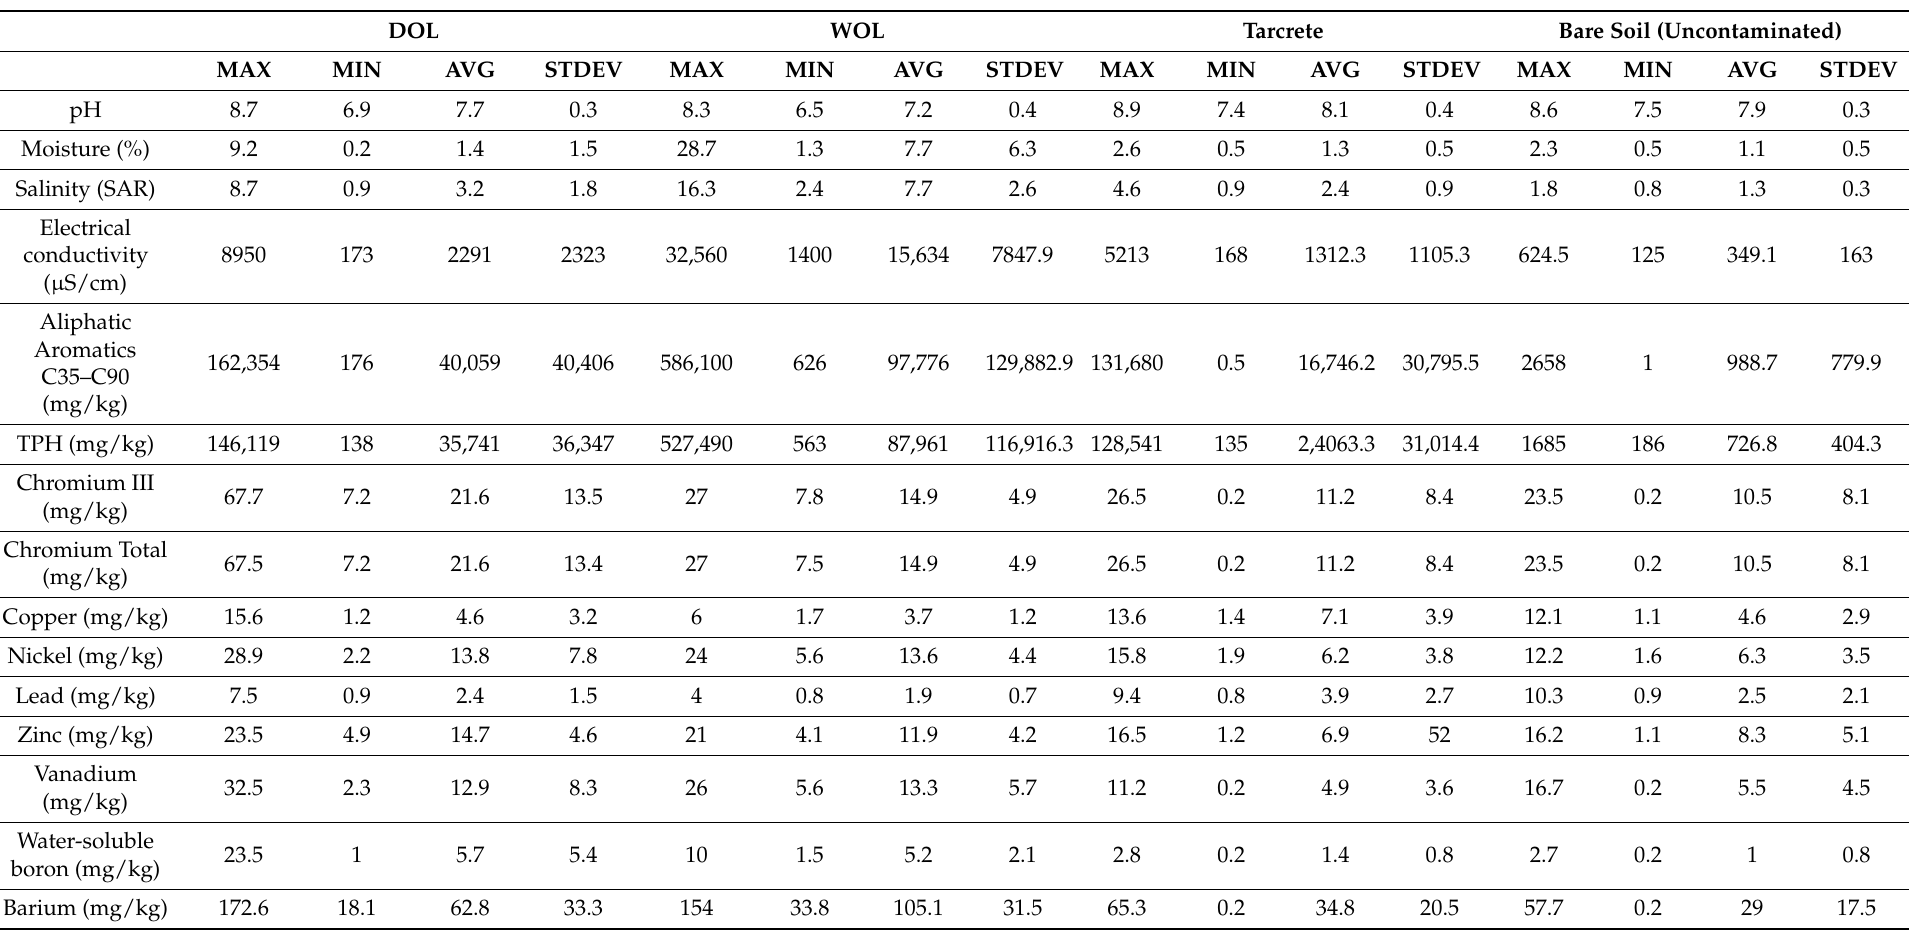
Table 3. Results of soil-parameter analysis (minimum, maximum, average, and standard deviation) in the four categories. MAX, maximal value; MIN, minimal value; AVG, average value; and STDEV, standard